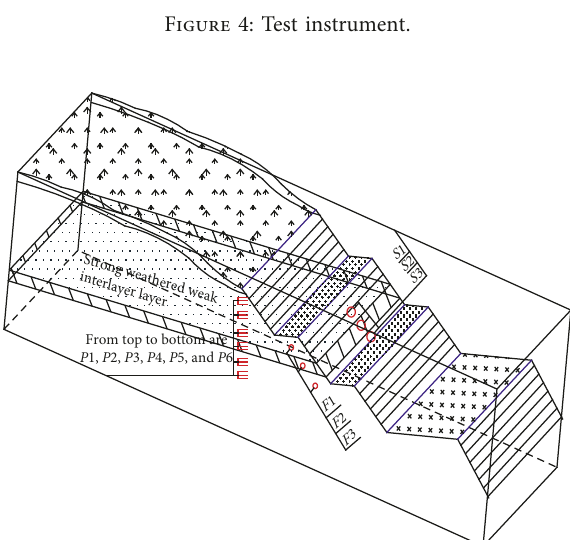
Figure 5: Layout of monitoring points. P is the monitoring point of volume water content, F is the sliding thrust monitoring point, and S is the displacement monitoring point.